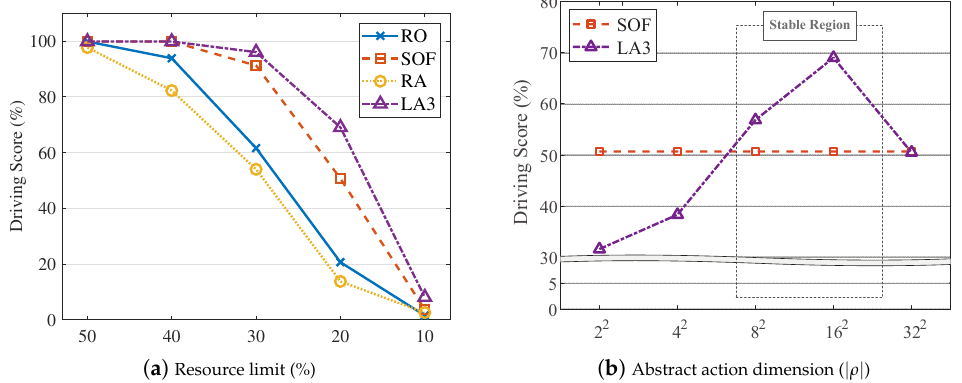
( b ) Abstract action dimension ( | ρ | ) Figure 19. Performance evaluation: ( a ) we configure the resource limit in percentages at several stages (on the X-axis) and denote the driving score; ( b ) we configure the dimension of abstract actions | ρ | (on the X-axis). ( b ) For the VOL scale of 40 2 , we observe stable performance highly better than SOF with | ρ | = 8 2 ,16 2 , but does not with | ρ | = 2 2 ,4 2 ,32 2 .